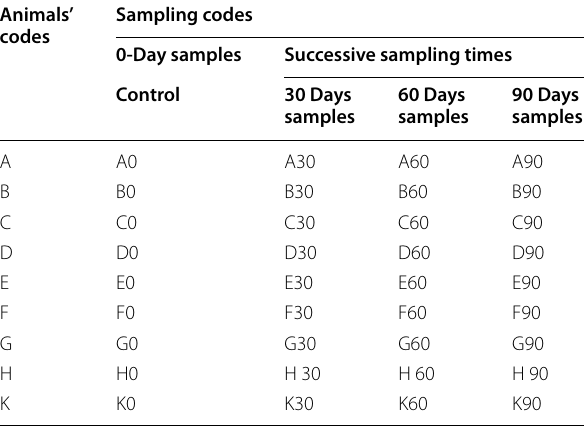
0-day samples are collected shortly before weaning; they represent control samples for the three successive collected samples from the same corresponding rat after GM-feeding durations of 30, 60, and 90 days